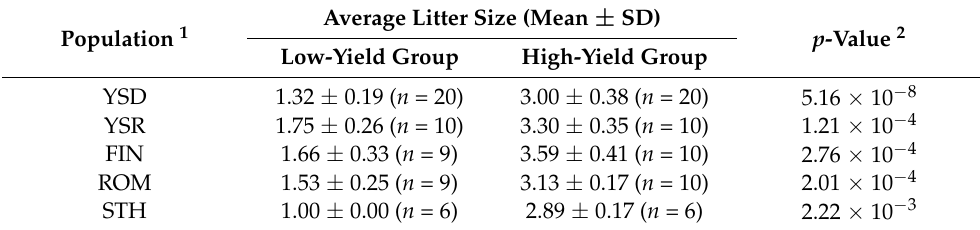
Table 1. Phenotypes of does and ewes used in this